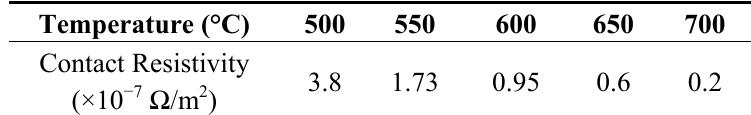
Table 3. Contact resistivity between current collector and electrodes at different operation temperature